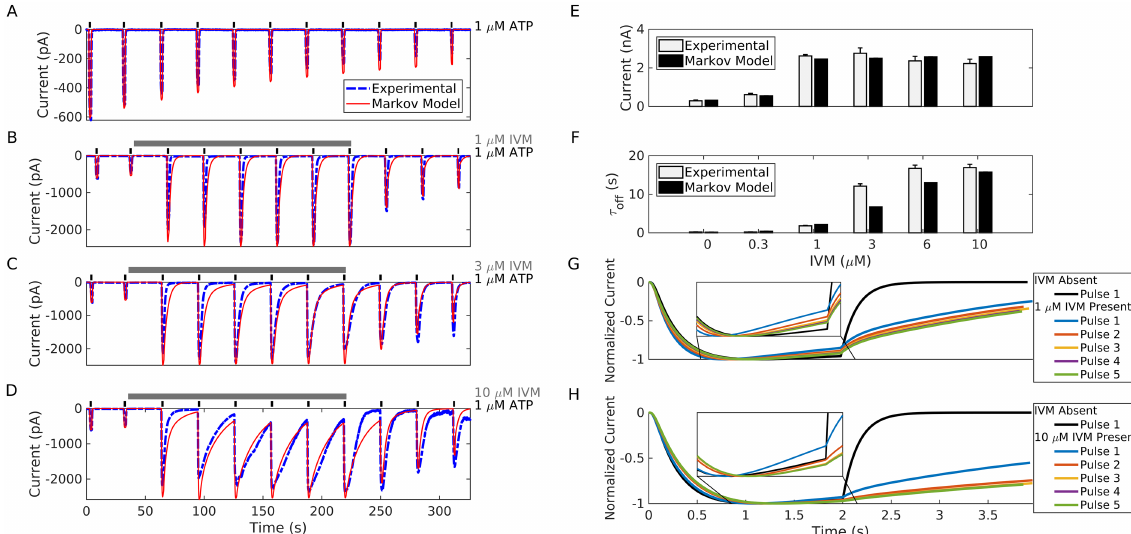
Fig 4. Outcomes of the two-layer model determined by the MCMC fitting to the pulse and prolonged protocols. (A-D) Simulated time series of current for the pulse protocol performed with (A) 0, (B) 1, (C) 3, and (D) 10 μ M IVM. Dashedblue lines, experimental recordings; solid red lines, simulations. (E, F) IVM-dependent concentration-responsechangesin (E) peak current amplitudeand (F) rate of receptor deactivation. Model deactivationkinetics τ off measuredby the weightedtime constant. (G, H) Progression of activation, desensitization, and deactivationof currents producedby the model and normalized by maximum amplitudes duringthe pulse protocol in the presenceof 1 μ M (G) and 10 μ M (H) IVM. Insets show the magnifieddesensitization phases of the response. All experimental data are derived from